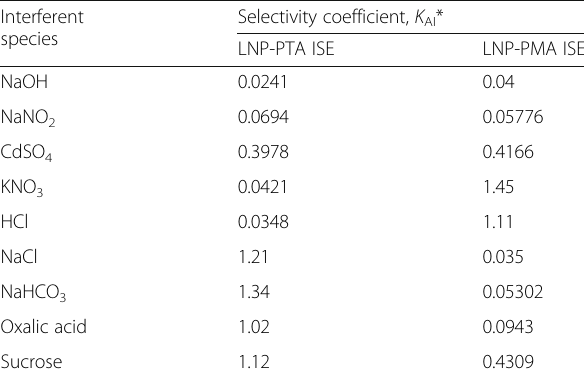
Table 2 Results of interference study and determination of selectivity coefficients ( K AI )